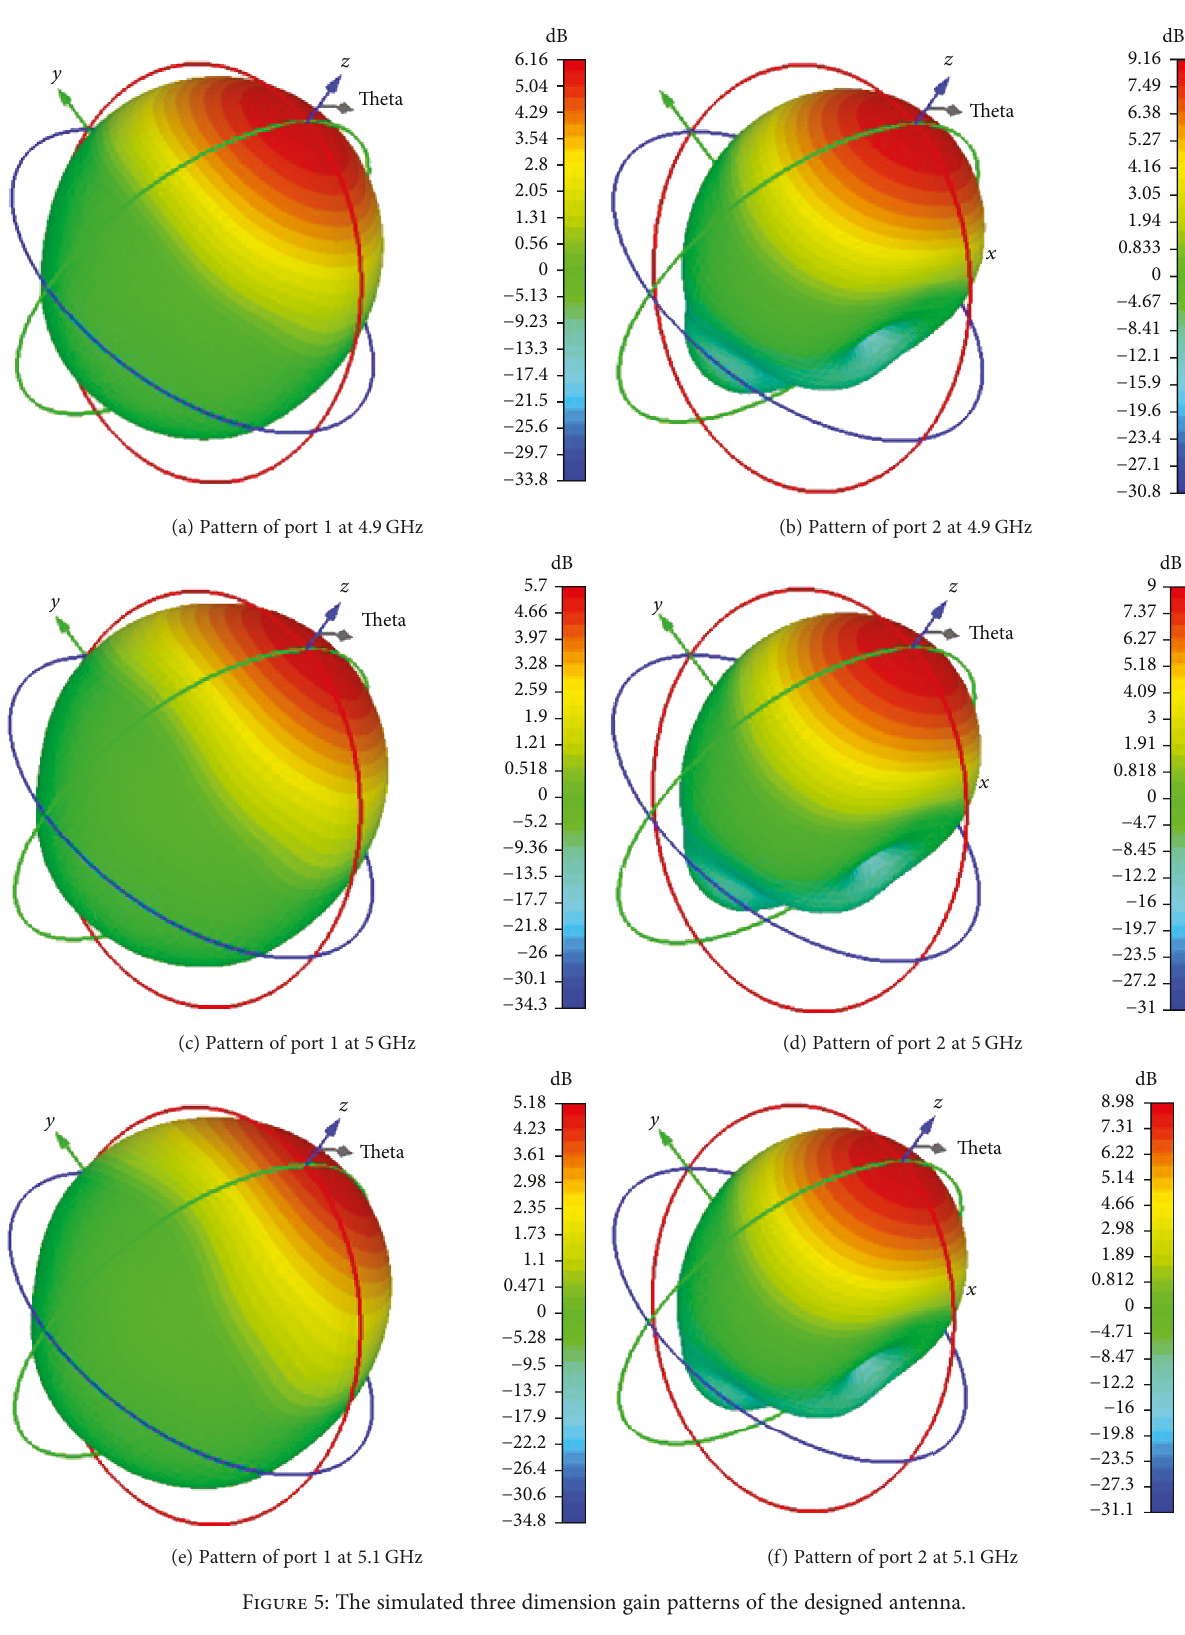
Figure 5: The simulated three dimension gain patterns of the designed